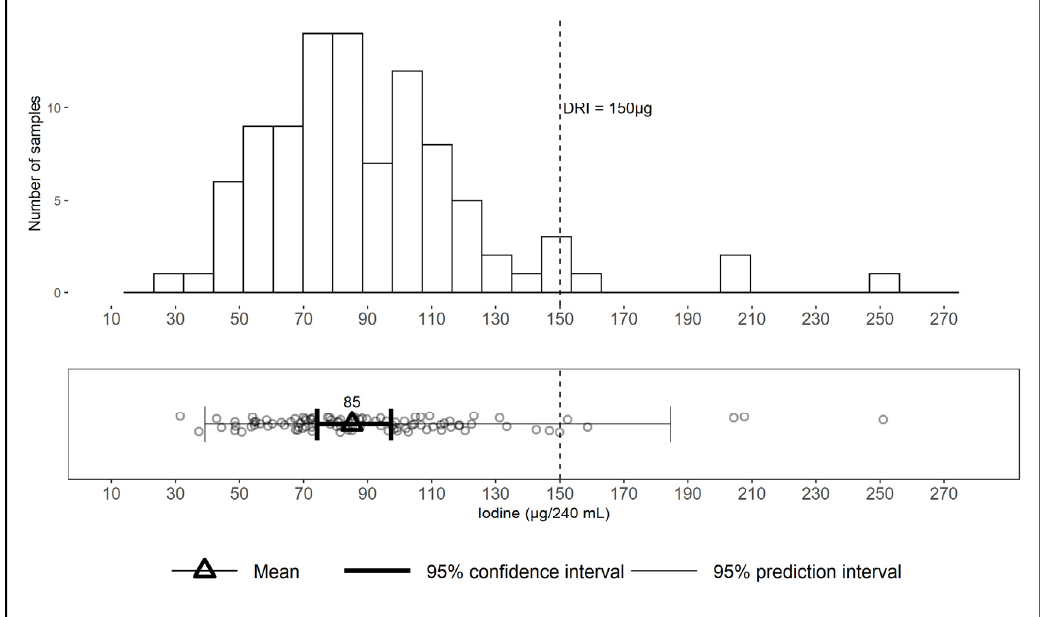
Figure 3. Iodine content of retail samples of milk in the U.S. ( n = 96) per 240 mL serving, shown as distribution, mean, 95% confidence interval, and 95% prediction interval. DRI = Dietary Reference Intake